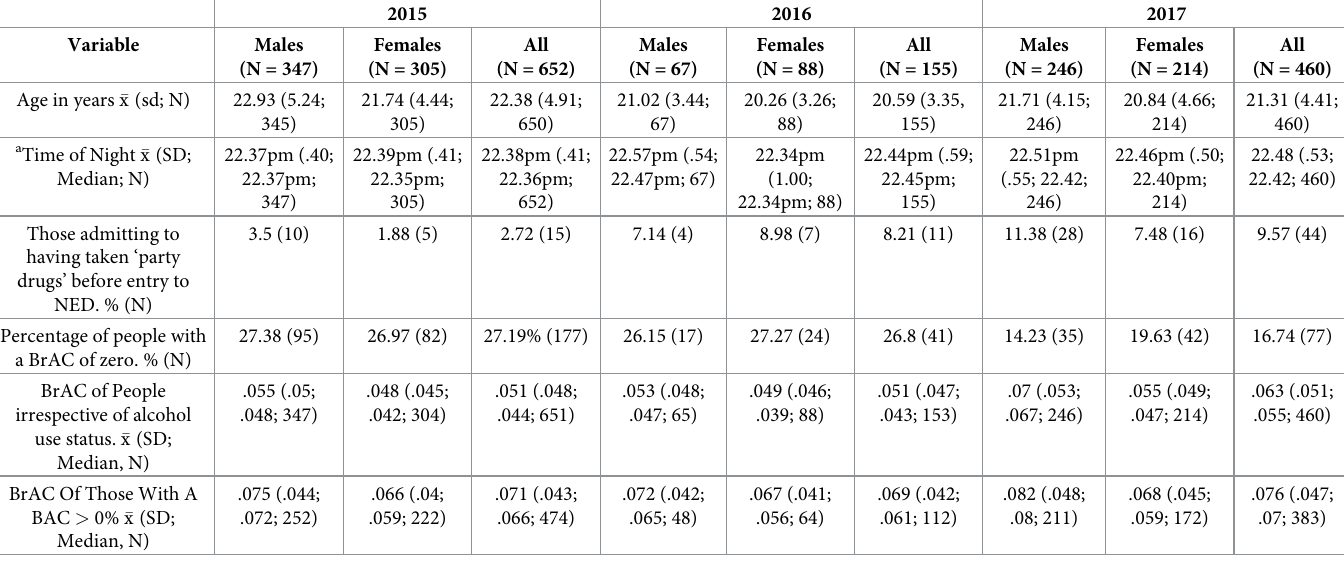
Table 6. January & February entry data for 2015, 2016 &